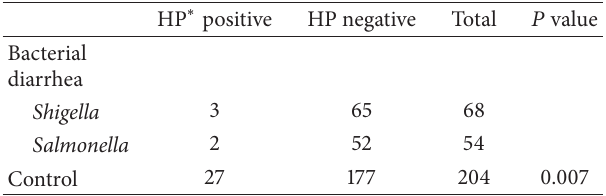
Table 1: H. pylori prevalence in different